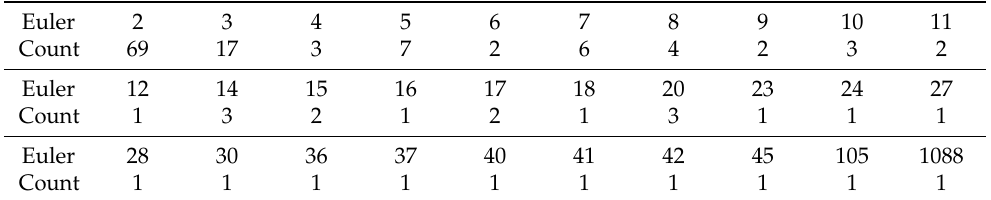
Table 5. Third decomposition type—distribution of combinatorial Euler characteristics of Tetrahe- dron3DNet objects from interior overlay.